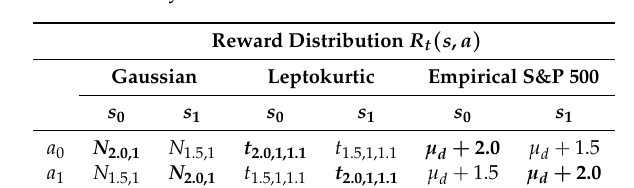
Table 1. Reward Distributions: Three Cases. The optimal policy (highlighted in bold) is π ( s i ) = a i for 0,1 . N l ,1 is the normal distribution with mean l and scale (standard deviation) 1, t l ,1,1.1 is the i ∈ { } location-scale student t -distribution with location l , scale 1, and degrees of freedom equal to 1.1, and µ d is the empirical distribution of daily returns of the S&P 500